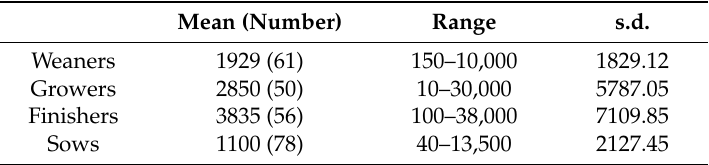
Table 6. Mean number of pigs kept at each stage of production at any one time (in brackets are the number of farmers that kept pigs at the specified stage of production), range and standard deviation